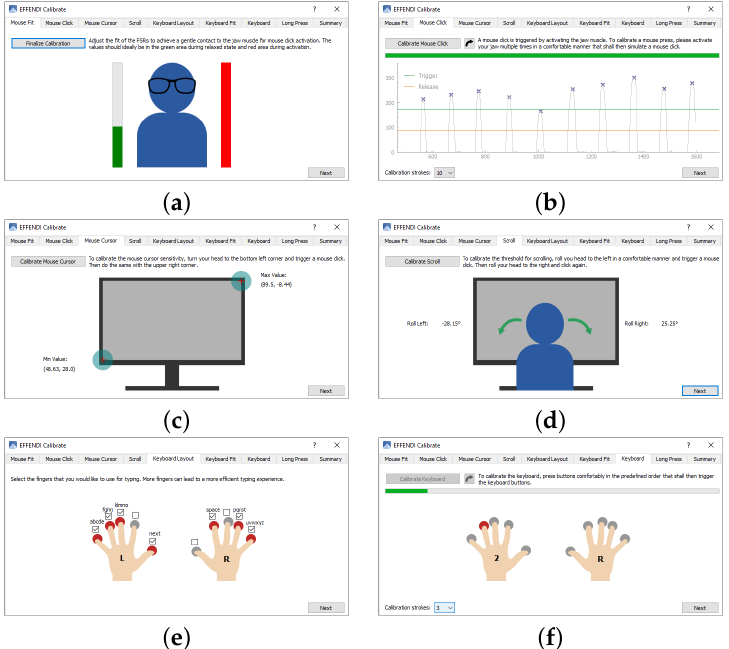
Figure 8. User interface during the guided calibration process. ( a ) Calibration of the force between the sensor and the Temporalis muscle. ( b ) Calibration of the threshold to activate a mouse click. ( c ) Calibration of the cursor sensitivity based on screen size. ( d ) Calibration of thresholds for scrolling. ( e ) Calibration of the keyboard layout based on usable fingers. ( f ) Calibration of the duration from a long button